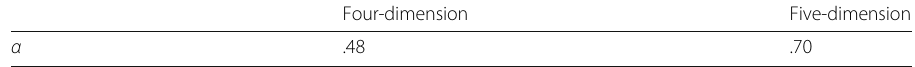
Table 2 Internal consistency of our four- and five-dimensional rubrics Four-dimension Five-dimension α .48